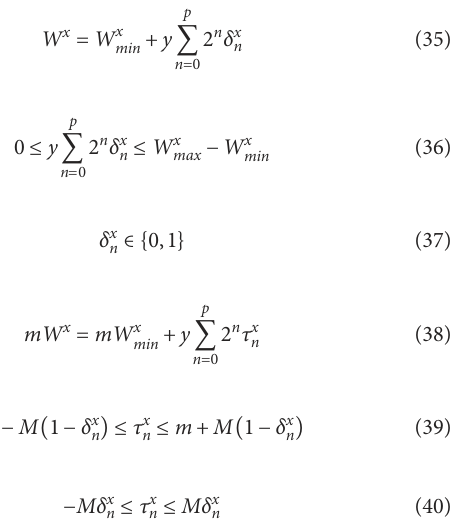
hydrogen power and the capacity of HFC. ( 33 ) and ( 34 ) represent the climbing constraint and the upper and lower temperature constraints for HFC,